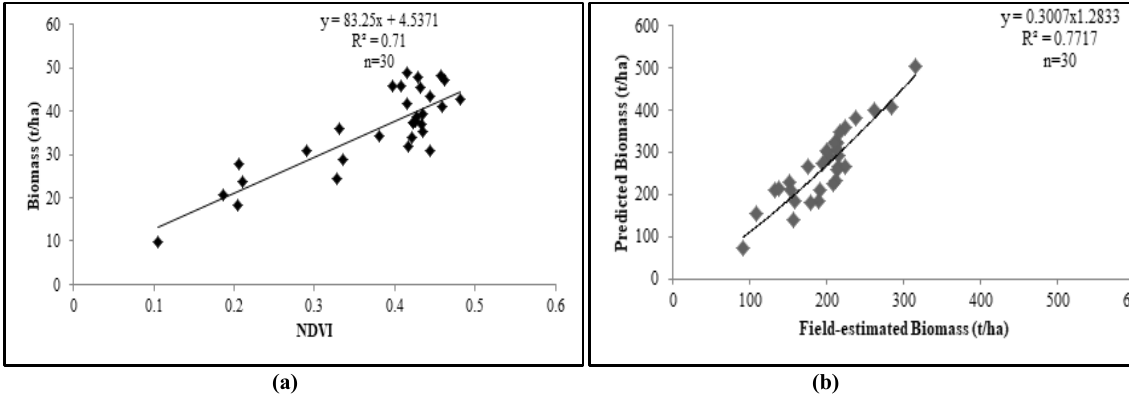
Fig. 4. Correlation between (a). NDVI and biomass and (b). predicted and field estimated